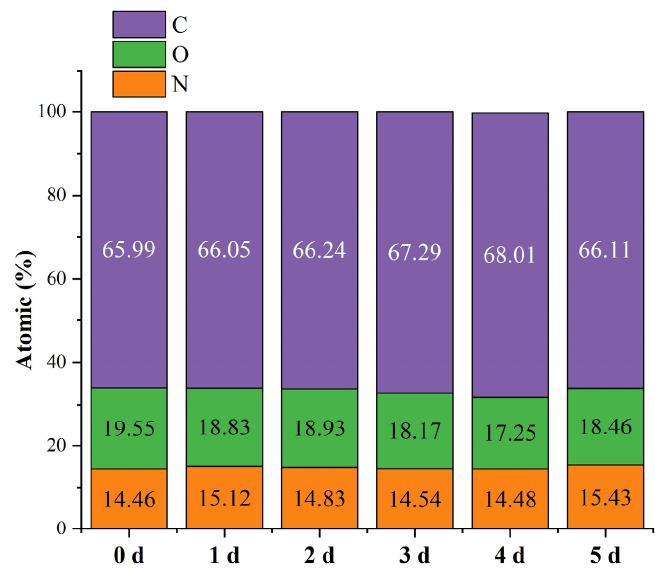
Figure 8. Elemental compositions (atomic%) of the gelatin/zein/glucose nanofiber film surfaces after Maillard reactions conducted at 60 °C and 50% RH for 0~5 days. The three characteristic peaks observed at 284.7, 286.2, and 288.0 eV in the high-res- olution C1s spectra in Figure 9 correspond to C-C/C=C, C-O/C-N, and O-C=O, respectively [39]. The C-C/C=C proportion was observed to increase from 40.98% to 43.26%, while C- O/C-N and O-C=O decreased from 41.01% to 35.66% and 18.01% decreased to 16.15%, respectively, over the first four days; these trends appeared to pick up by the fifth day, consistent with the occurrence of Maillard reactions.